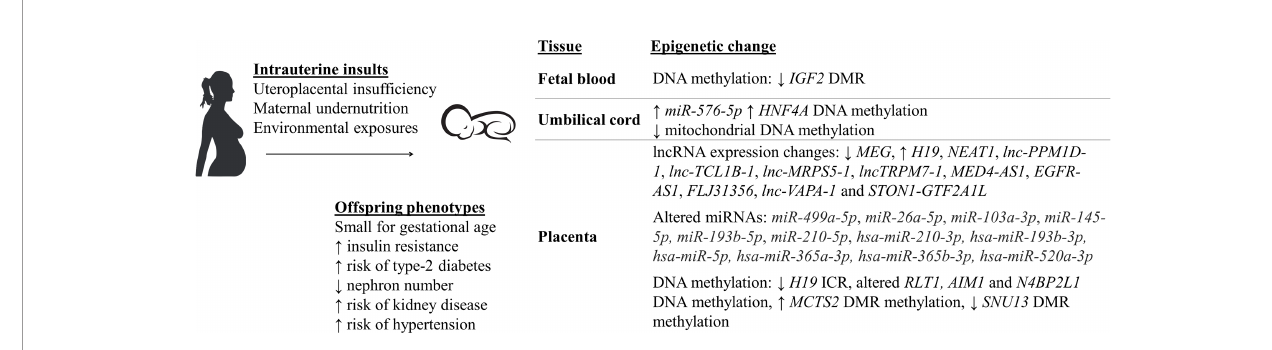
FIGURE 1 | Small for gestational age (SGA) babies who were exposed to intrauterine insults have altered epigenetic mechanisms and aberrant physiological changes, predisposing them to an increased risk of developing various chronic diseases later in life (5 – 8, 19 –